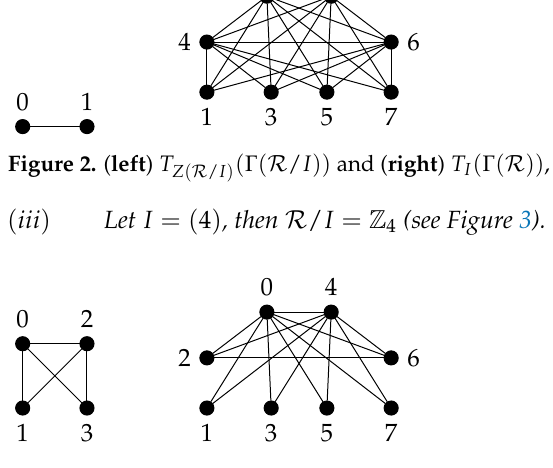
Figure 3. ( left ) T Z ( R / I ) ( Γ ( R / I )) and ( right ) T I ( Γ ( R )) , when R = Z 8 and I = ( 4 ) . ( iv )